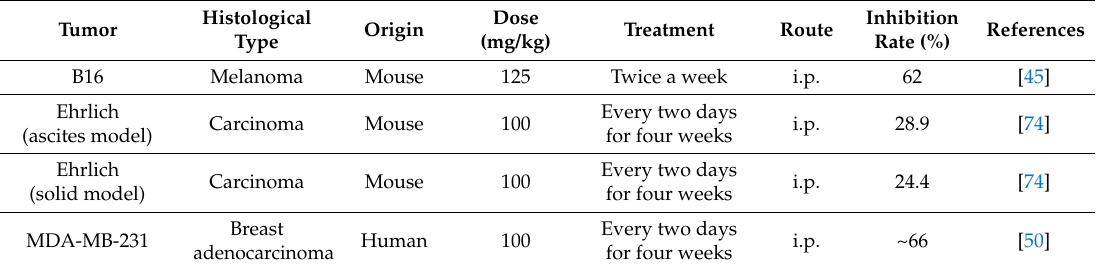
Table 3. Summary of in vivo antitumor effect of